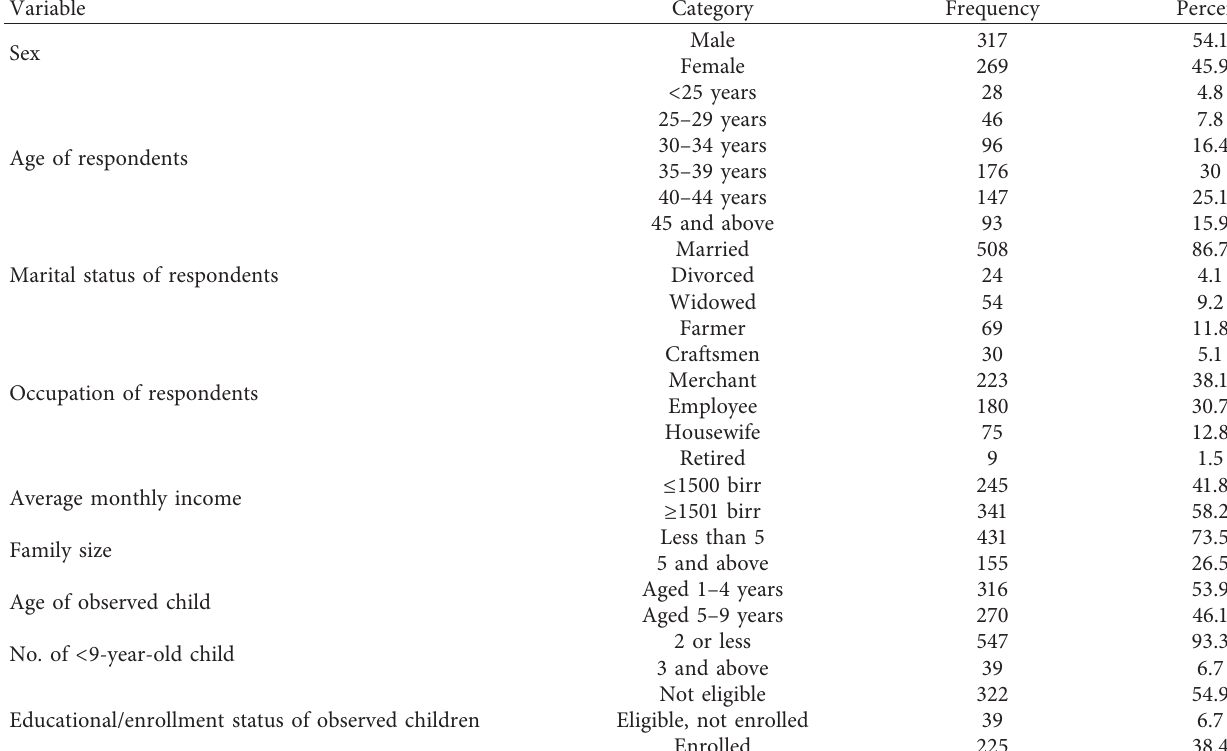
Table 1: Sociodemographic characteristics of respondents in Areka Town in Southern Ethiopia, 2018 ( N � 586).